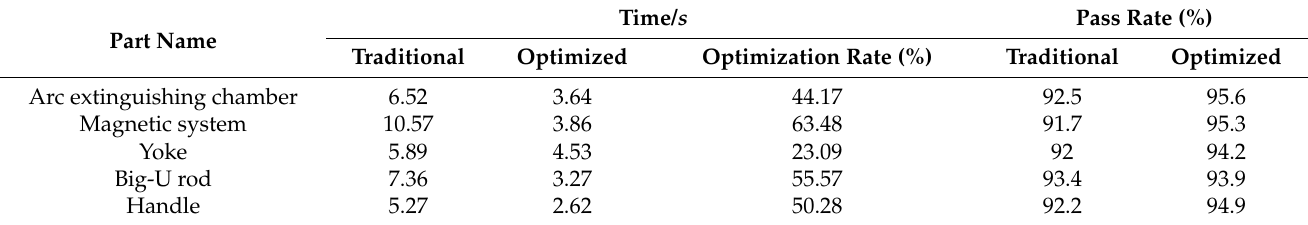
Table 2. Comparison of time and success rate of grasping five parts before and after